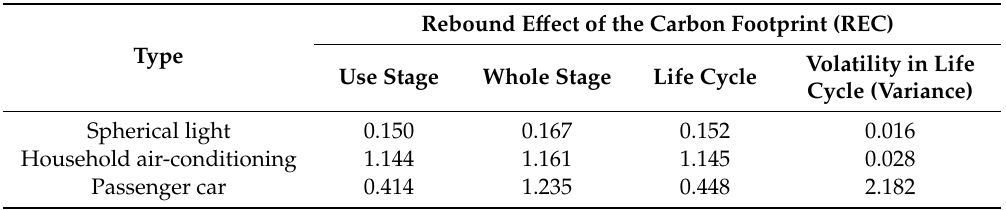
Table 2. The rebound e ff ect of lighting, air conditioning and passenger cars in three